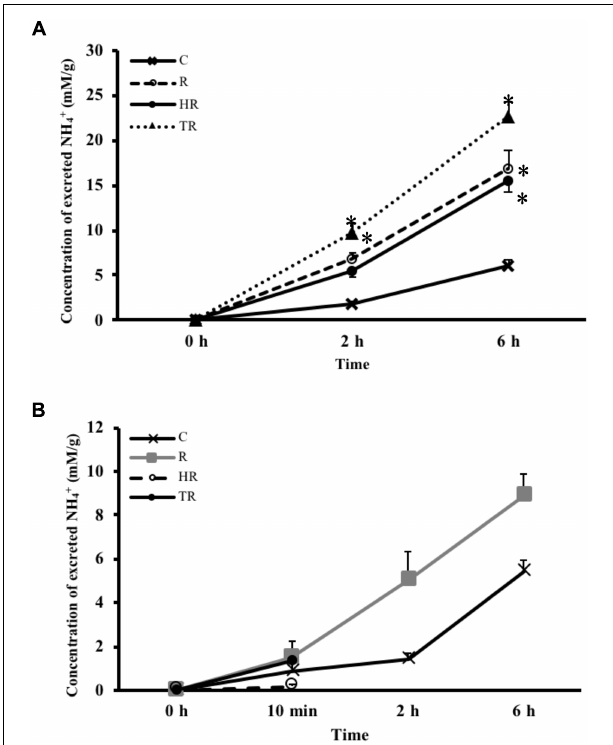
FIGURE 5 | Concentration of excreted NH 4 + from M. opercularis : (A) in control (C), hypoxic (H), thermal (T), and hypoxic-and-thermal (HT) ABR treatment groups at 0, 2, and 6 h ( n = 7–9); (B) NH 4 + concentrations in control (C), restricted (R), hypoxic (HR), thermal (TR) ABR-restricted treatment groups at 0 h, 10 min, 2 h and 6 h ( n = 7–9). Values that were significantly different ( p < 0.05) from control are indicated by an asterisk. There were no statistically significant differences among treatments and times. Data are presented as mean ± SEM.